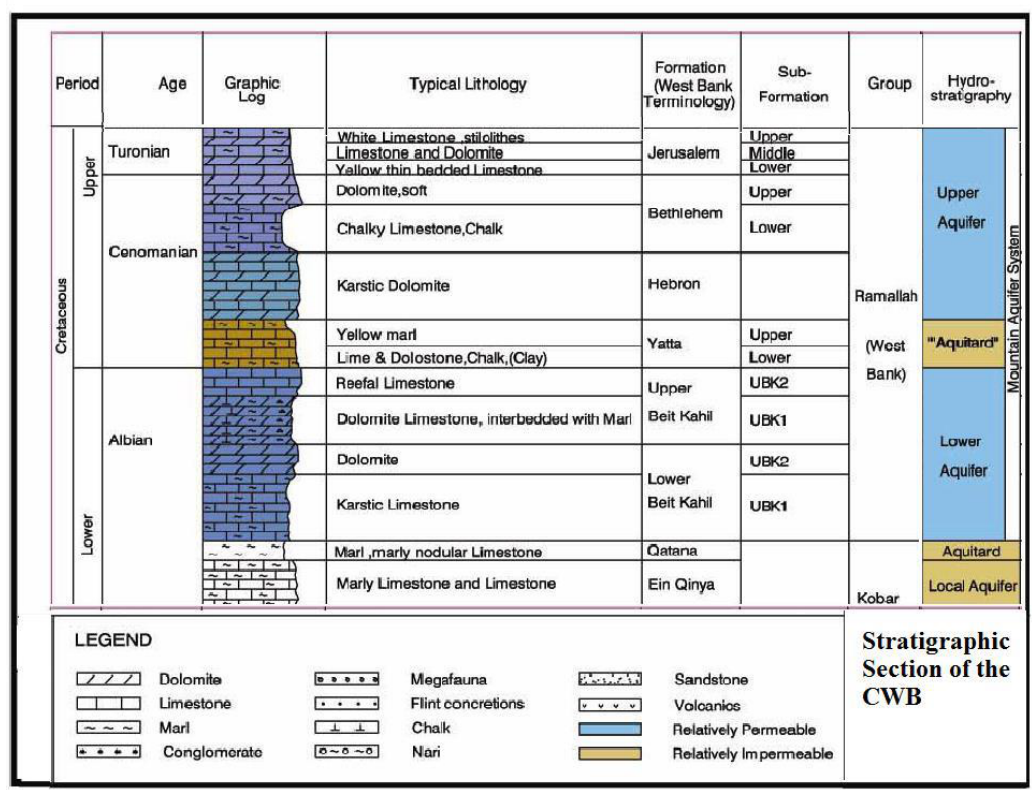
Figure 4. Lithostratigraphy column of the WAB [12].